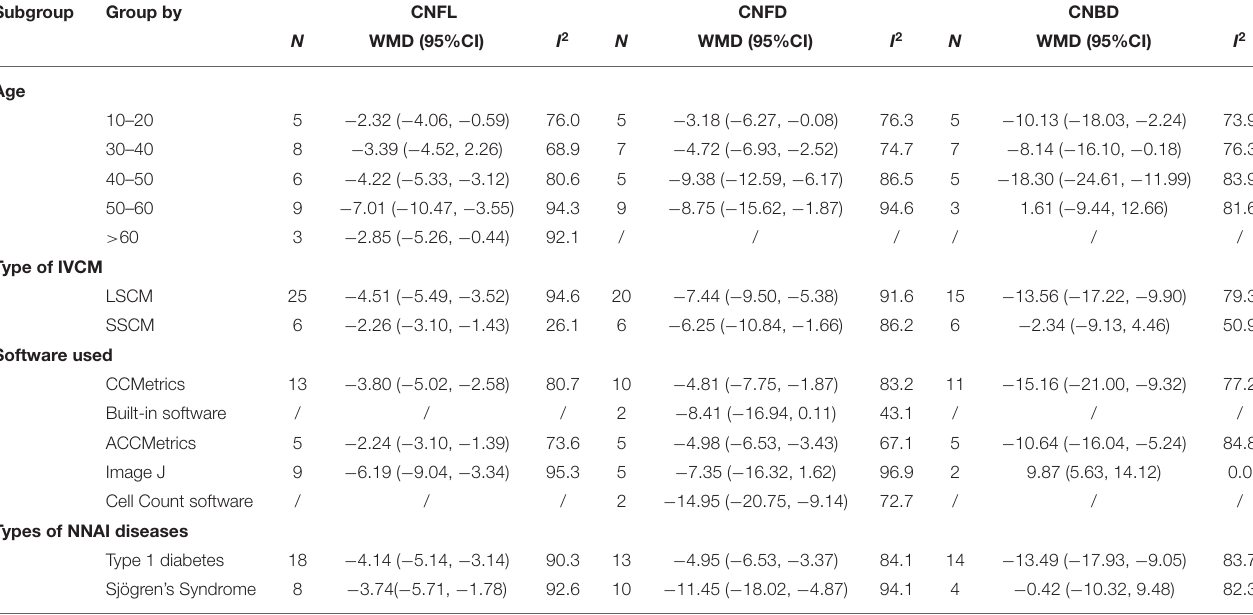
TABLE 3 | Subgroup analysis of CNFL, CNFD, and CNBD by age, type of IVCM, software used, and types of NNAI diseases.